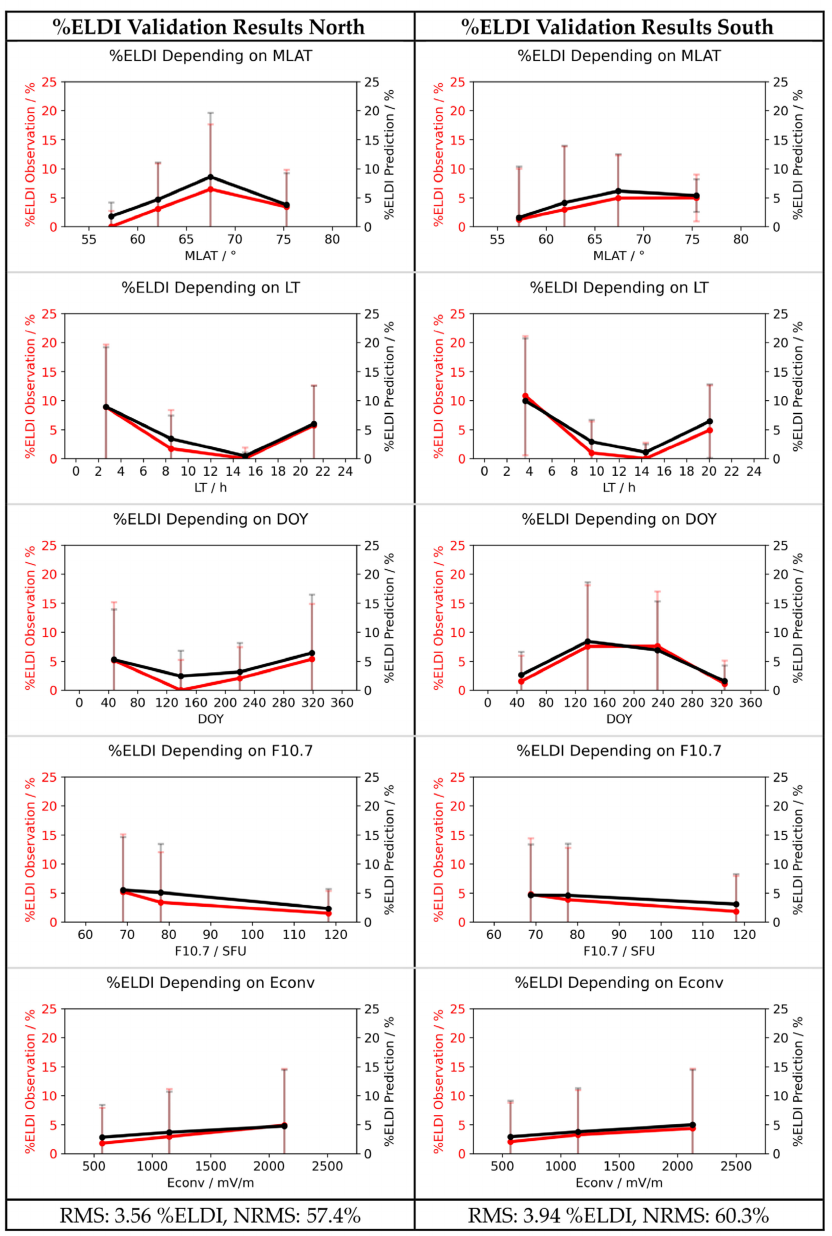
Figure 9. Observed (red) and predicted (black) %ELDI trends for the test dataset. ( Left ) North- ern Hemisphere. ( Right ) Southern Hemisphere. Last row: RMS and NRMS deviation between observation and